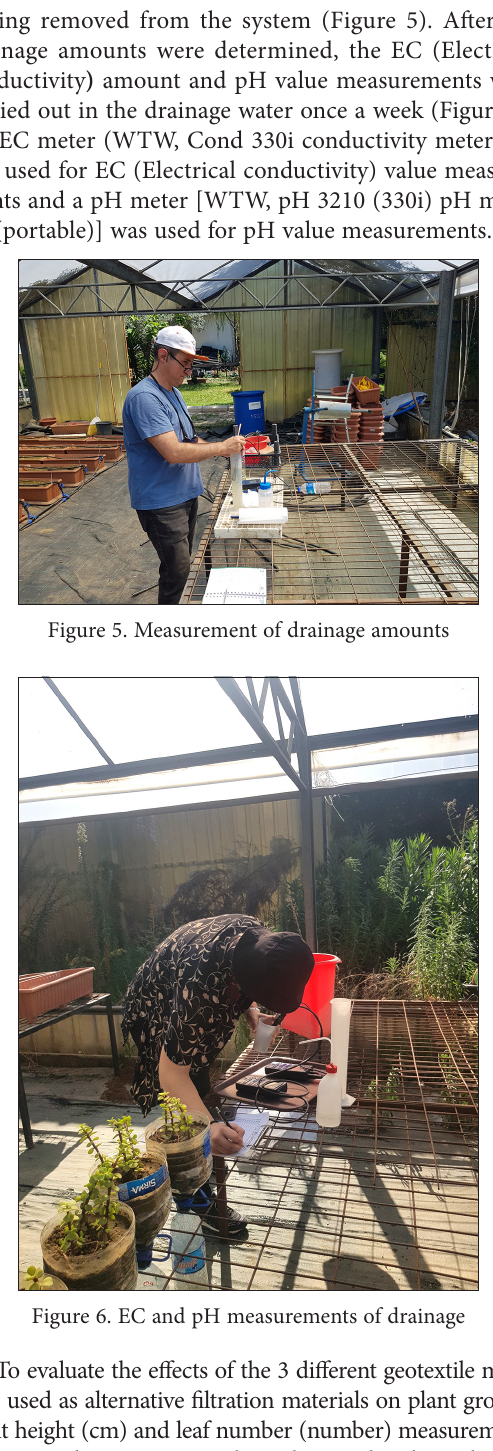
Table 1. The salinity (EC) values (μS/cm) of filtration materials Filtration